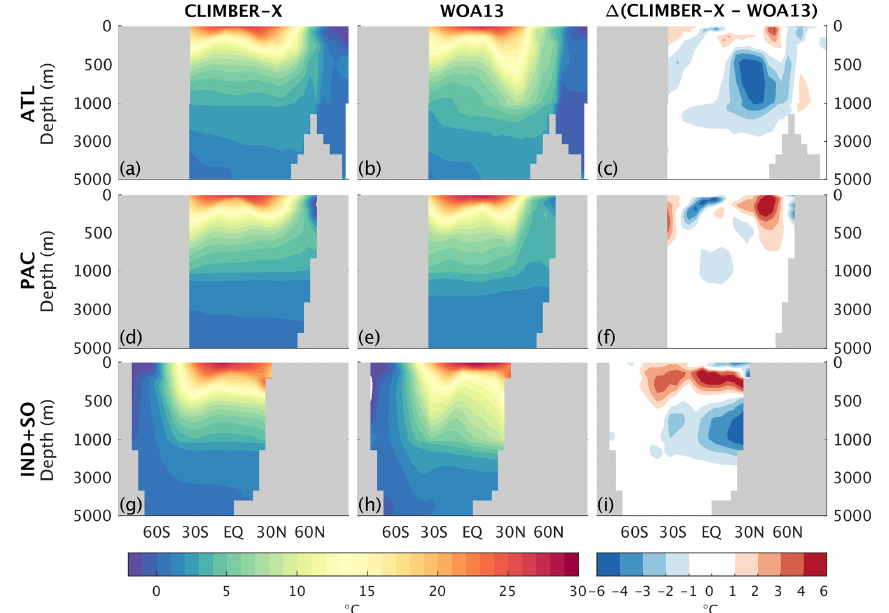
Figure 14. Zonal mean ocean temperature simulated by CLIMBER-X (a, d, g) compared to WOA13 data (Levitus et al., 2015) (b, e, h) for the (a, b, c) Atlantic, (d, e, f) Pacific, and (g, h, i) Indian and Southern oceans. Panels (c) , (f) , and (i) show the model bias.